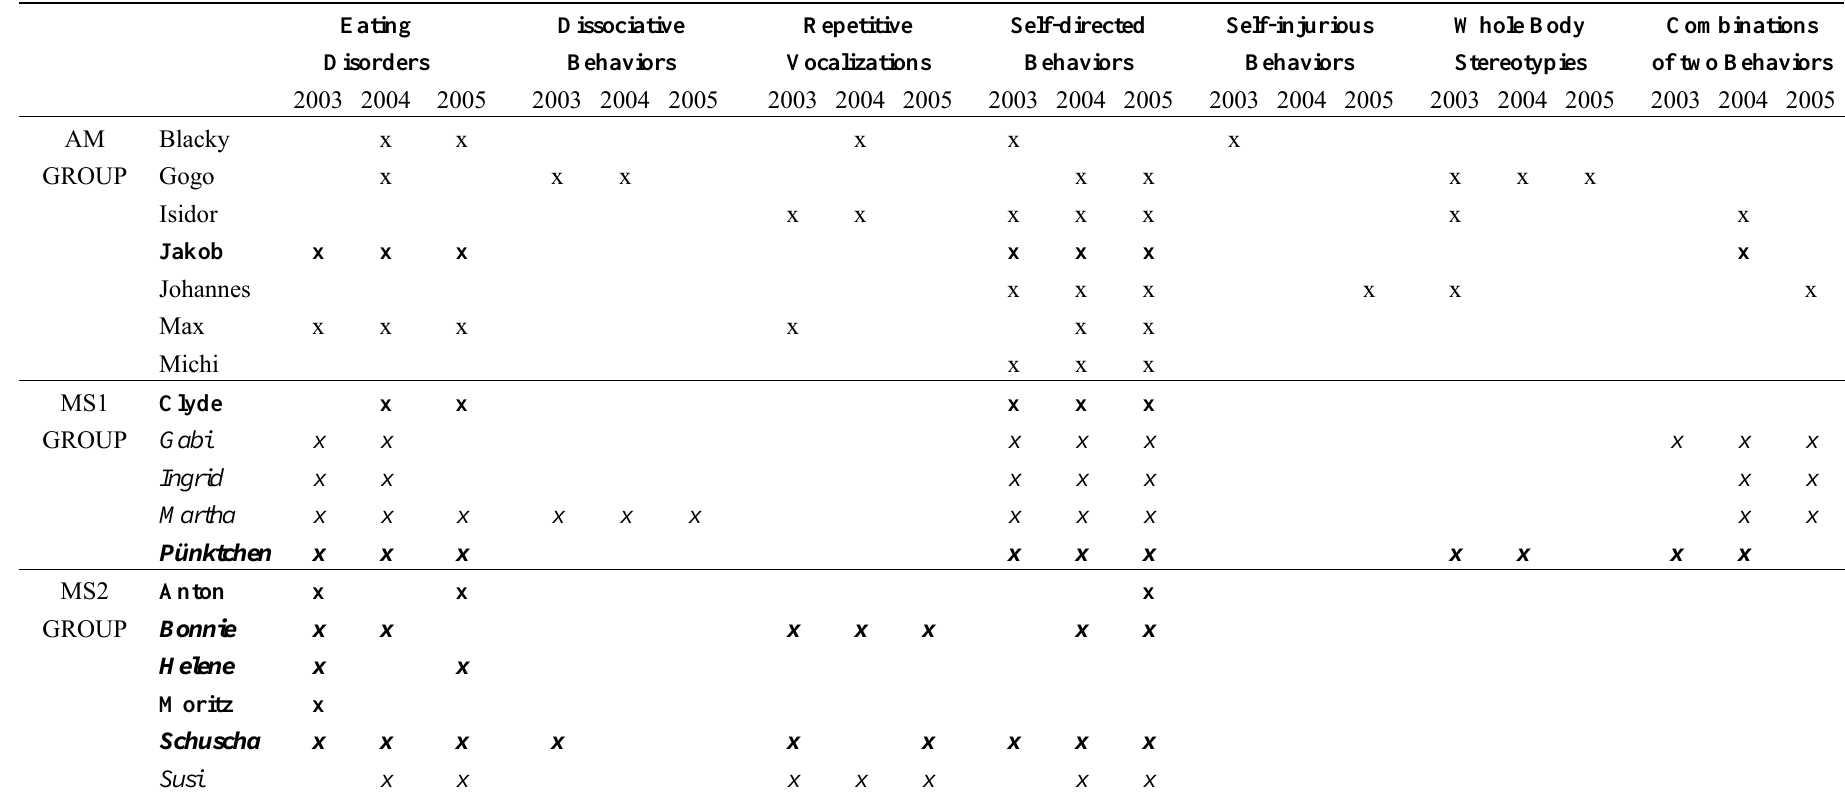
Table S1. Prevalence of the abnormal behavioral categories per individual and year.